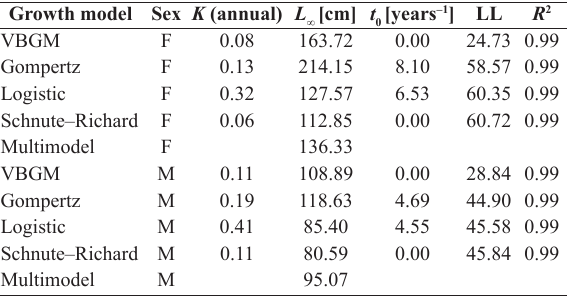
Table 3. Growth models parameter of the Pacific hake, Merluc- cius productus , for both sex.